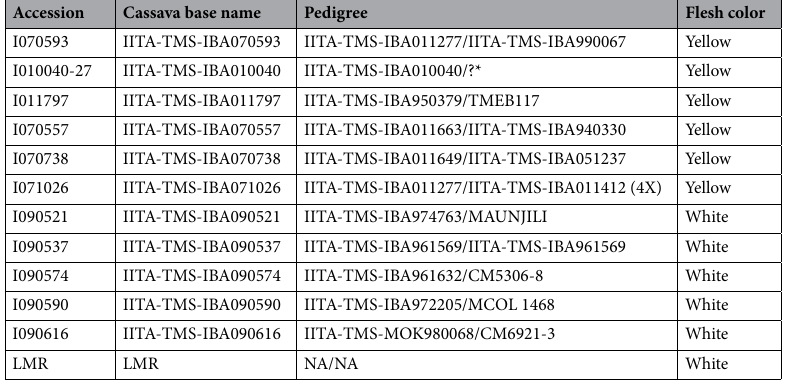
Table 4. Cassava genotypes used in the trial. */? Denote half